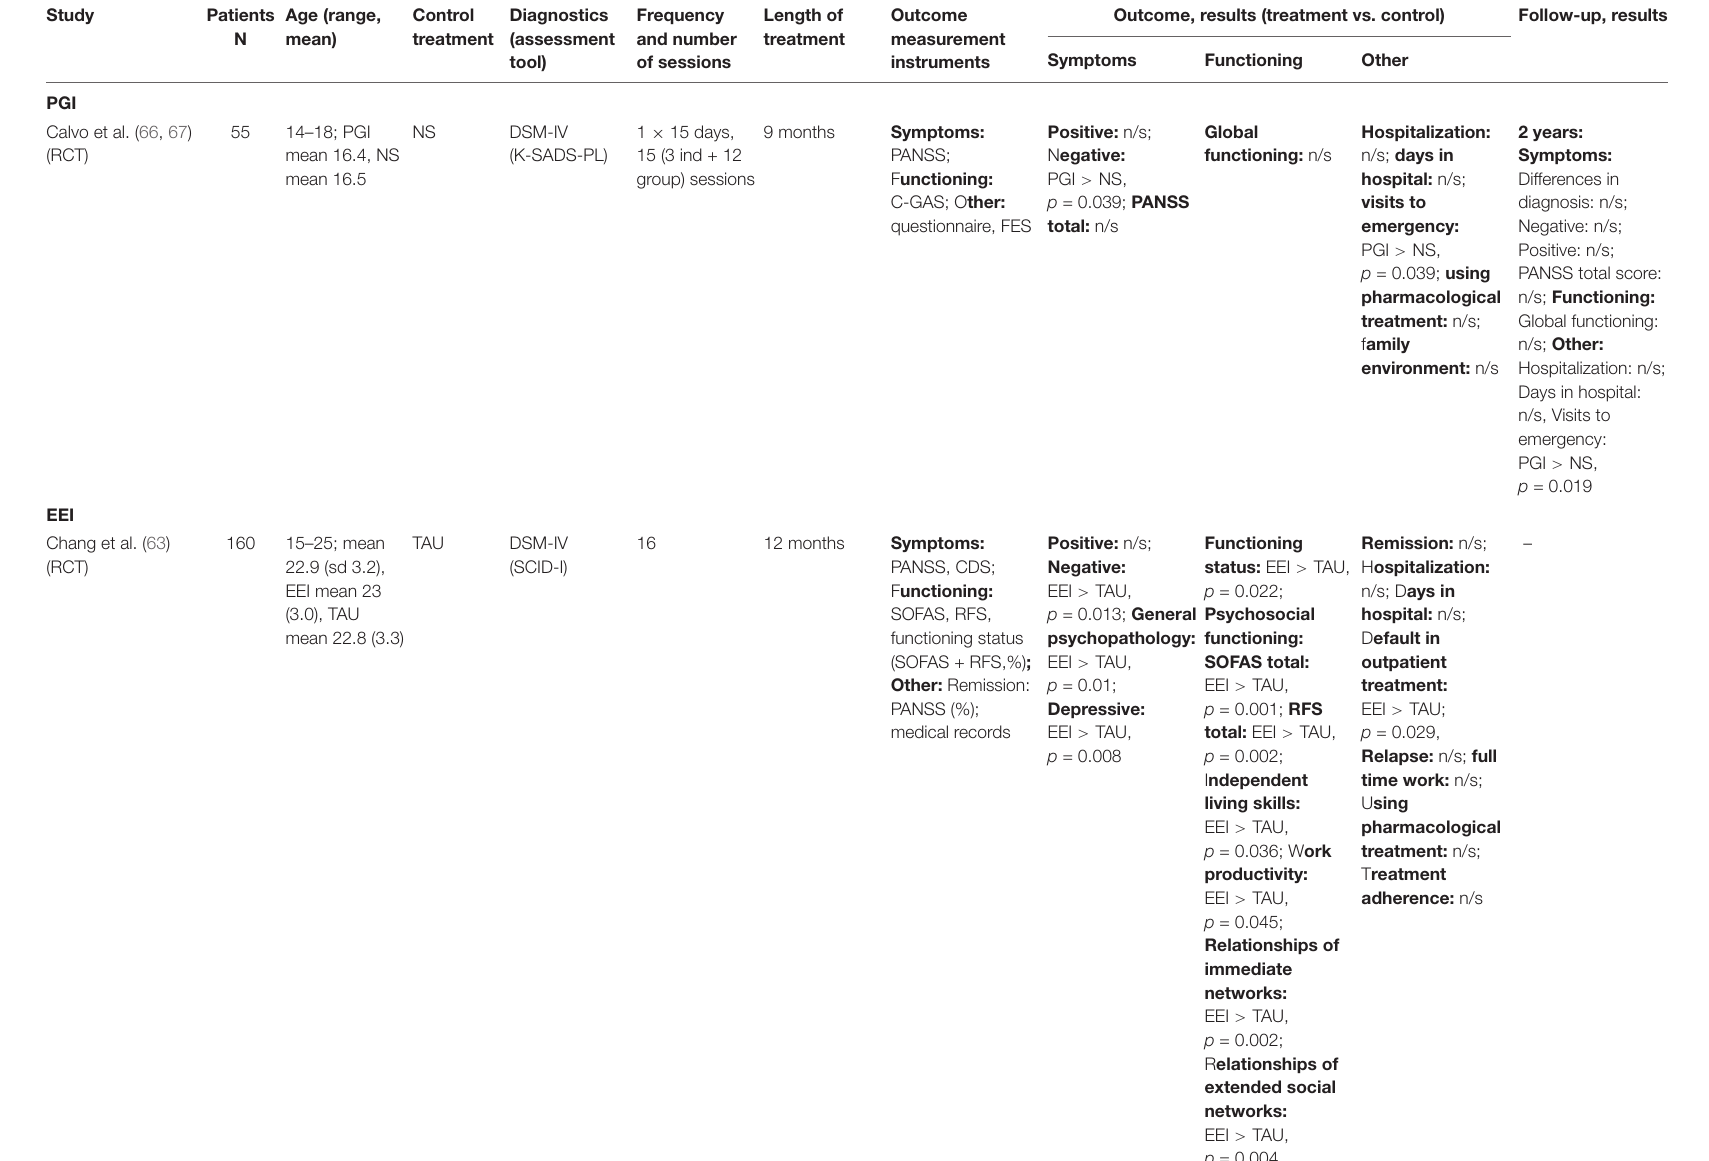
TABLE 4 | Studies concerning other psychological treatments for adolescents and young adults with psychotic